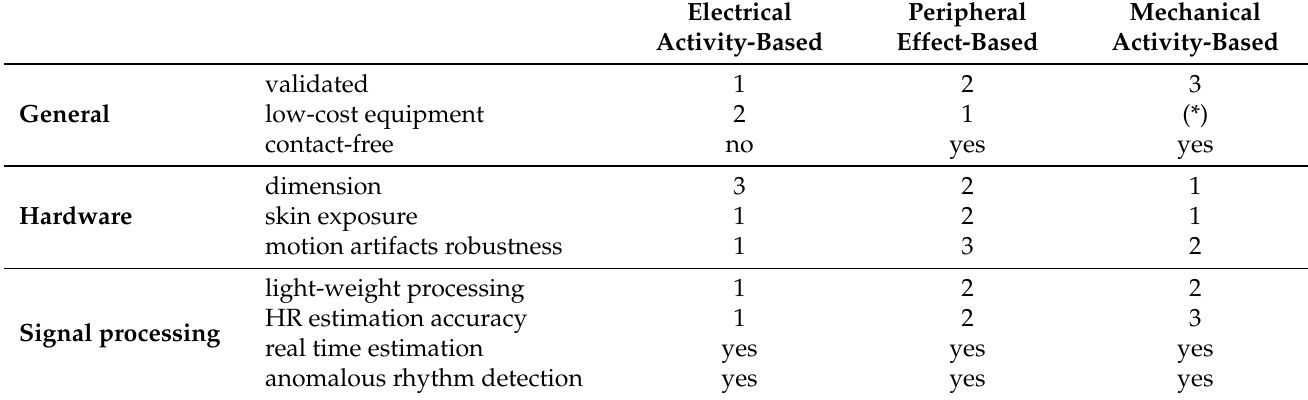
Table 3. Comparison between the three sensing categories (i.e., sensing of electrical activity, peripheral activity of the heart and mechanical activity). The considered criteria are divided in three classes (i.e., general, hardware and signal processing). When possible we introduced a ranking from best (rank = 1) to worst (rank = 3) of the sensing